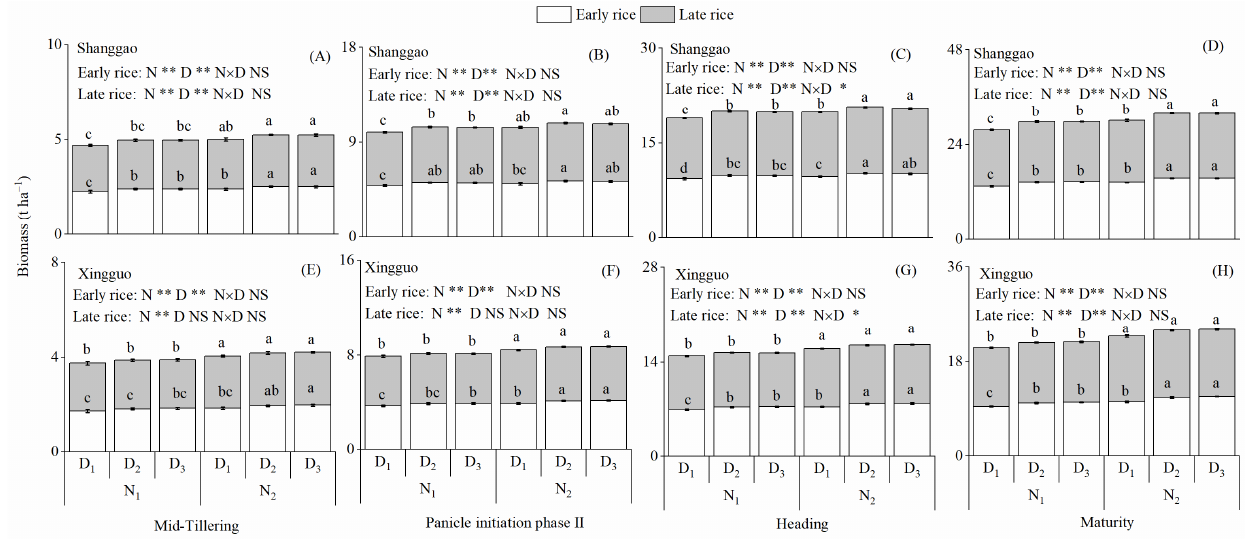
Figure 4. Biomass accumulation dynamics of double cropping rice ( A – H ) response to the N rate and plant density in two different ecological regions in 2018. N 1 and N 2 represent 120 and 150 kg ha − 1 for early rice and N 1 and N 2 represent 120 and 165 kg ha − 1 for late rice. D 1 , D 2 and D 3 represent 86, 143 and 200 plants per m 2 for early rice and D 1 , D 2 and D 3 represent 57, 114 and 172 plants per m 2 for late rice. Values followed by different lowercase letters are significantly different at the 0.05 level. NS, * and ** represent no significant difference and significant difference at the 5% and 1%